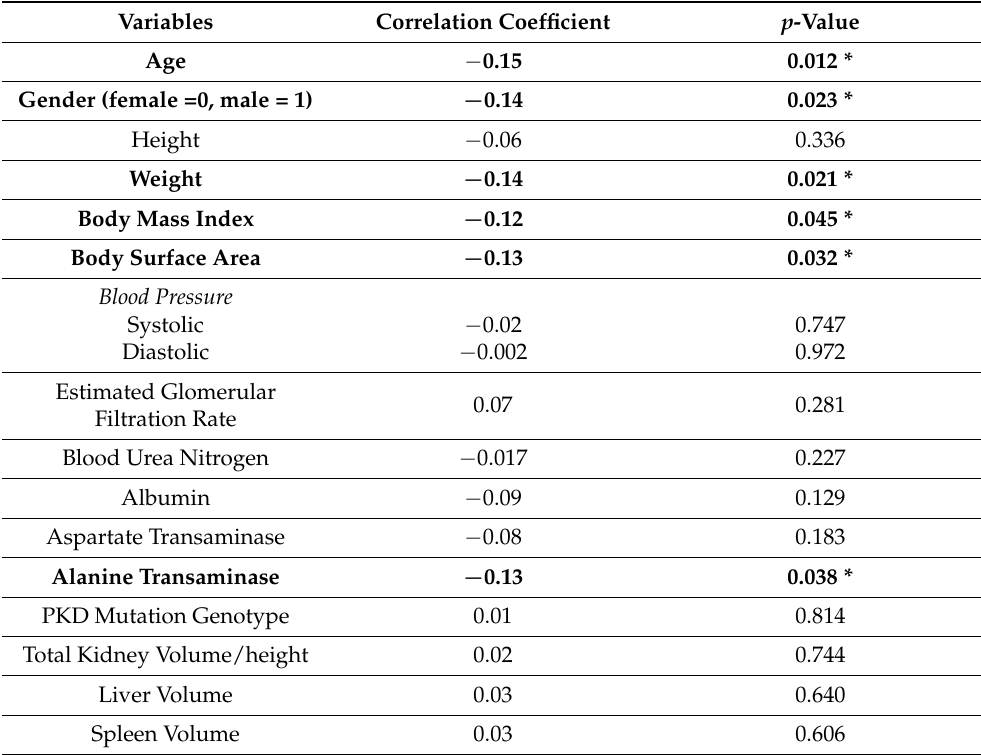
Table 4. Bivariate correlations between pleural effusion and clinical/laboratory variables in ADPKD